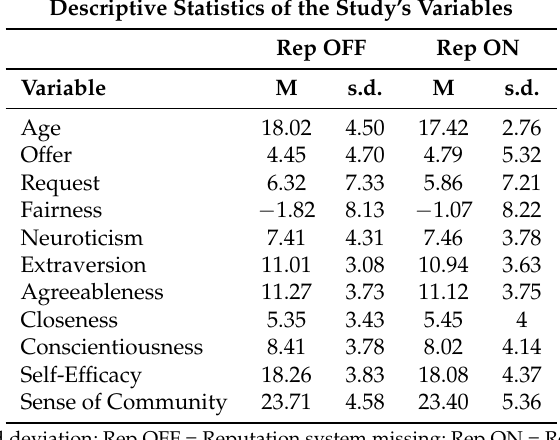
Table 3. Descriptive statistics. In the table are reported the participants’ socio-demographic and psychological characteristics, as well as their game behavior playing as proposers. Descriptive Statistics of the Study’s